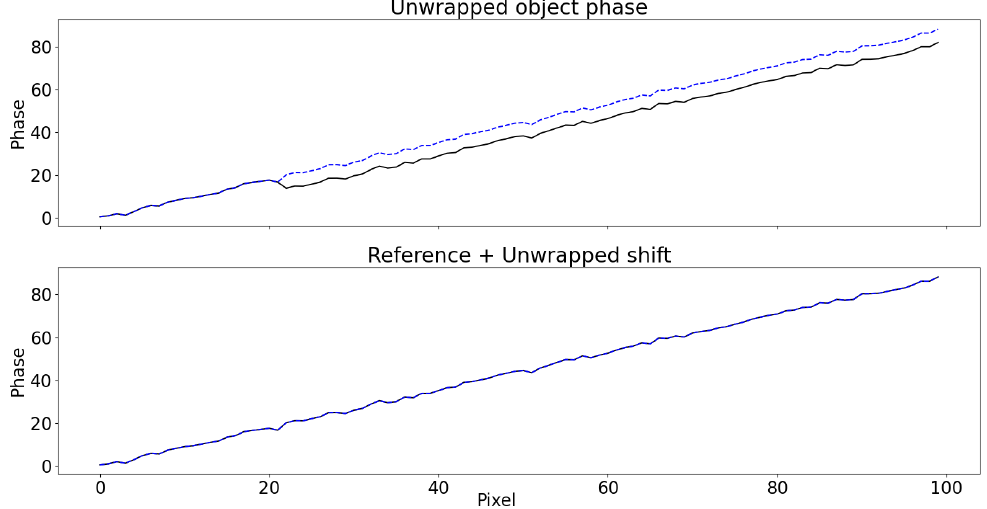
Figure 7. The unwrapped object phase (cid:101) Φ r ( u c , v c ) using ( top ) Equation (11) and ( bottom ) Equation (13) with respect to the original phase (dashed blue). In the first case, the noise causes the unwrapping algorithm to discard a genuine jump right after u c = 20, introducing error. This does not happen in the second case due to the reduced presence of 2 π